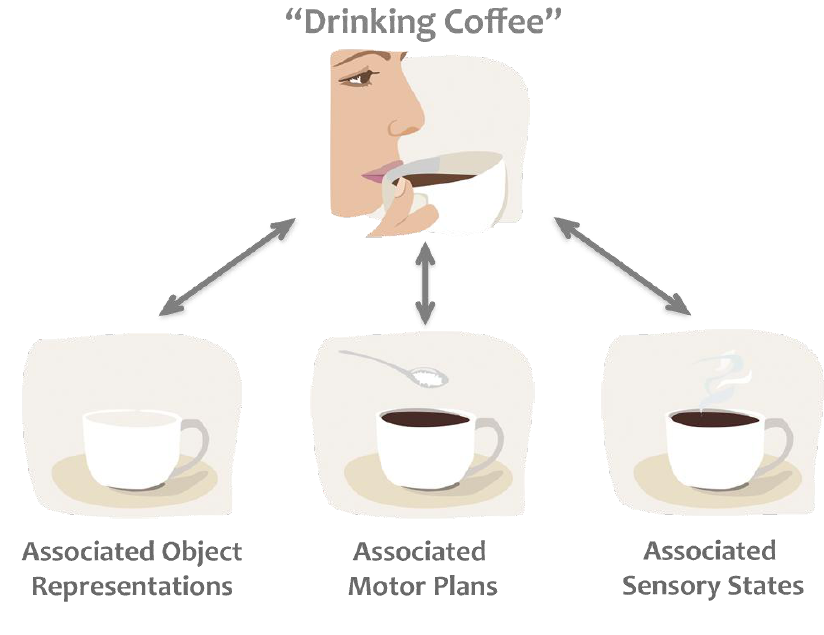
Figure 1. Example of the common coding theory. Thinking about “drinking